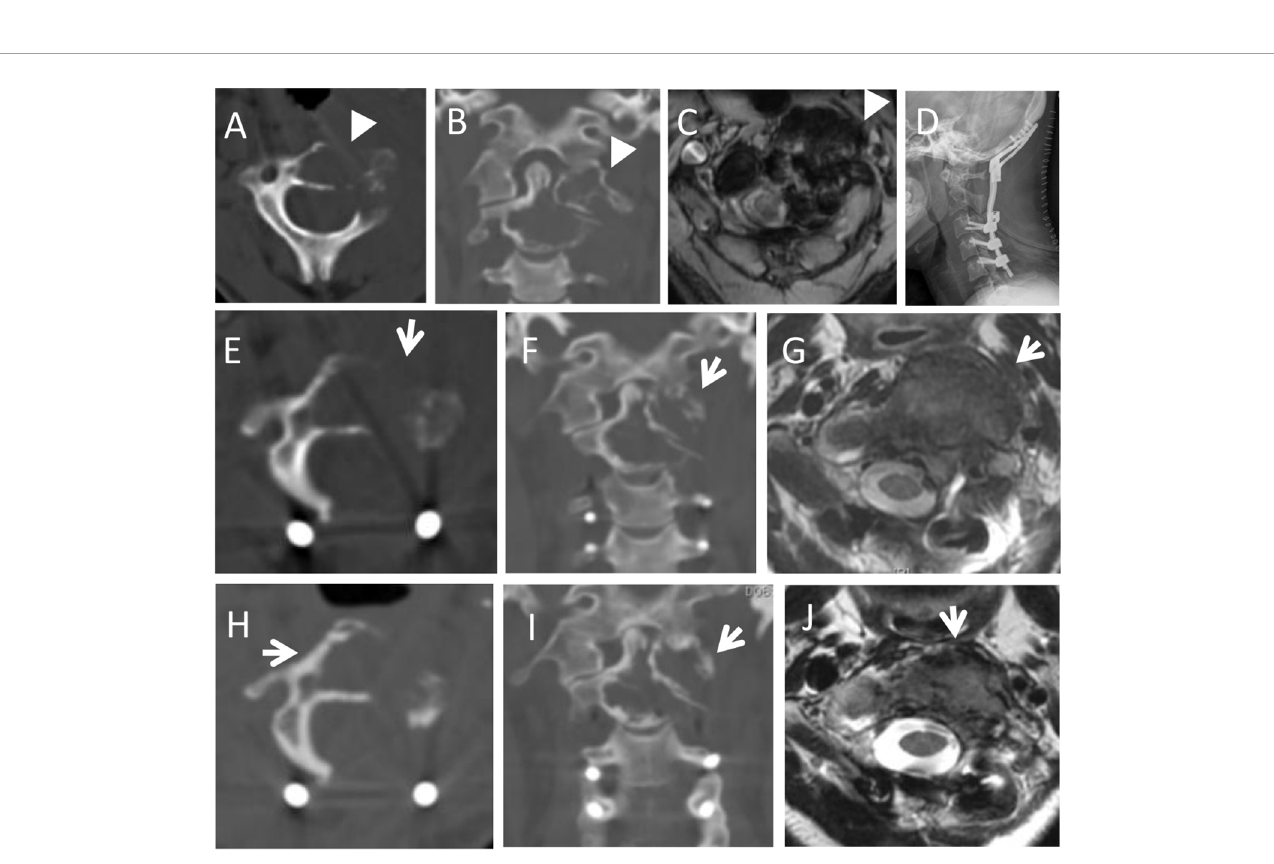
FIGURE 5 A 32-year-old female with neck pain for four months, and worsened in the following 2 months. Preoperative imaging examination showed an osteolytic lesion was located in the C1-2 (arrowheads in A, B ). She underwent STR because of lesion adhesion to the vertebral artery. In 3-month follow-up, CT and MRI scans revealed local progression with soft tissue mass (arrows in E,F,G ). She underwent radiotherapy. And at the 69-month follow-up, the lesion was stable and the volume of soft tissue mass was reduced with slight new bone around the osteolytic lesion (arrows in H,I,J ). (A,B) : Preoperative axial and coronal CT scans; (C) : T2-weighted axial MRI scans; (D) : Postoperative X-ray; (E,F) : Axial and coronary CT scans in 3rd month after surgery; (G) : T2- weighted axial MRI scan at the 3-month follow-up after surgery; (H – J) : Axial and coronary CT scans, and T2-weighted axial MRI scan at the 69-month follow-up after